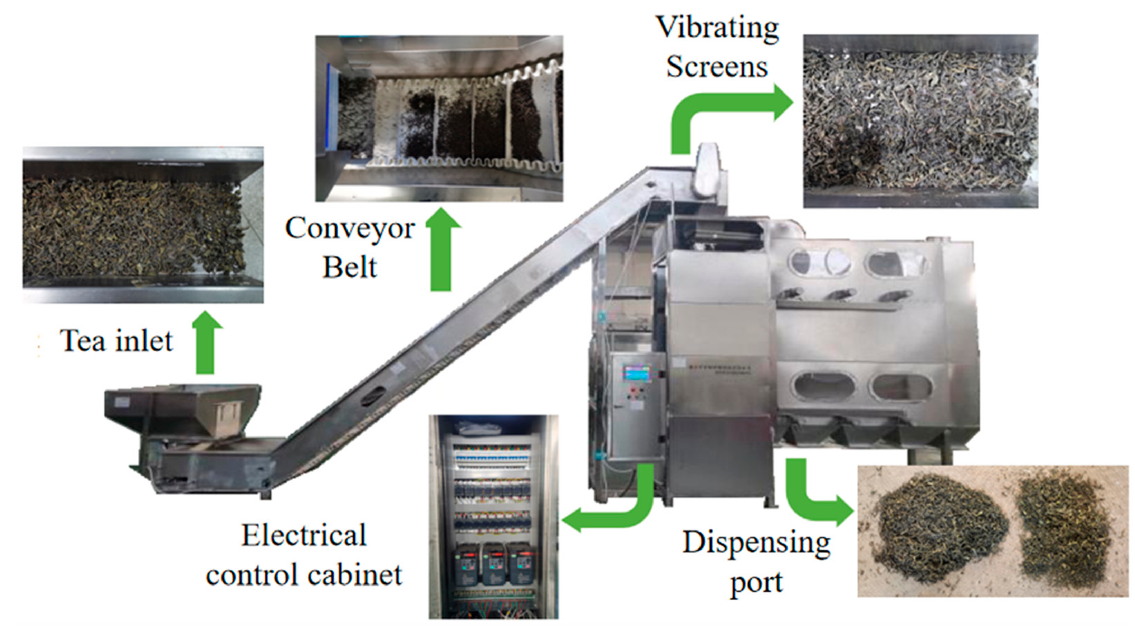
Figure 2. Double-layer tea winnowing machine workflow scene diagram.